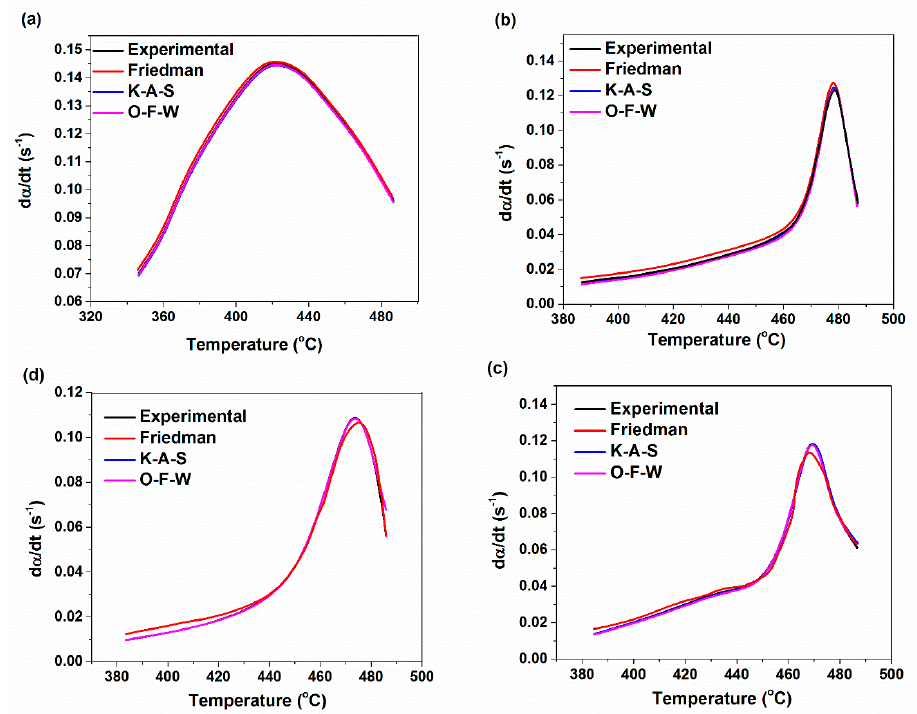
Figure 15. Predicted kinetics curves based on the autocatalytic degradation reaction model for XNBR/epoxy/XHNT nanocomposites containing various nanotube loadings at the heating rate of 5 °C/min for: ( a ) XE15; ( b ) XE15H3; ( c ) XE15H5 and ( d ) XE15H7.